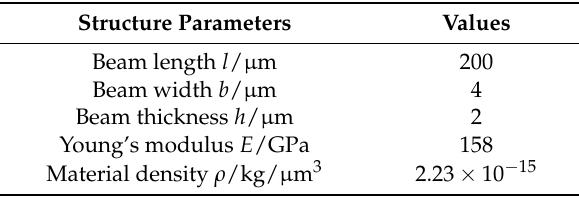
Table 1. Design parameters for a doubly-clamped beam.